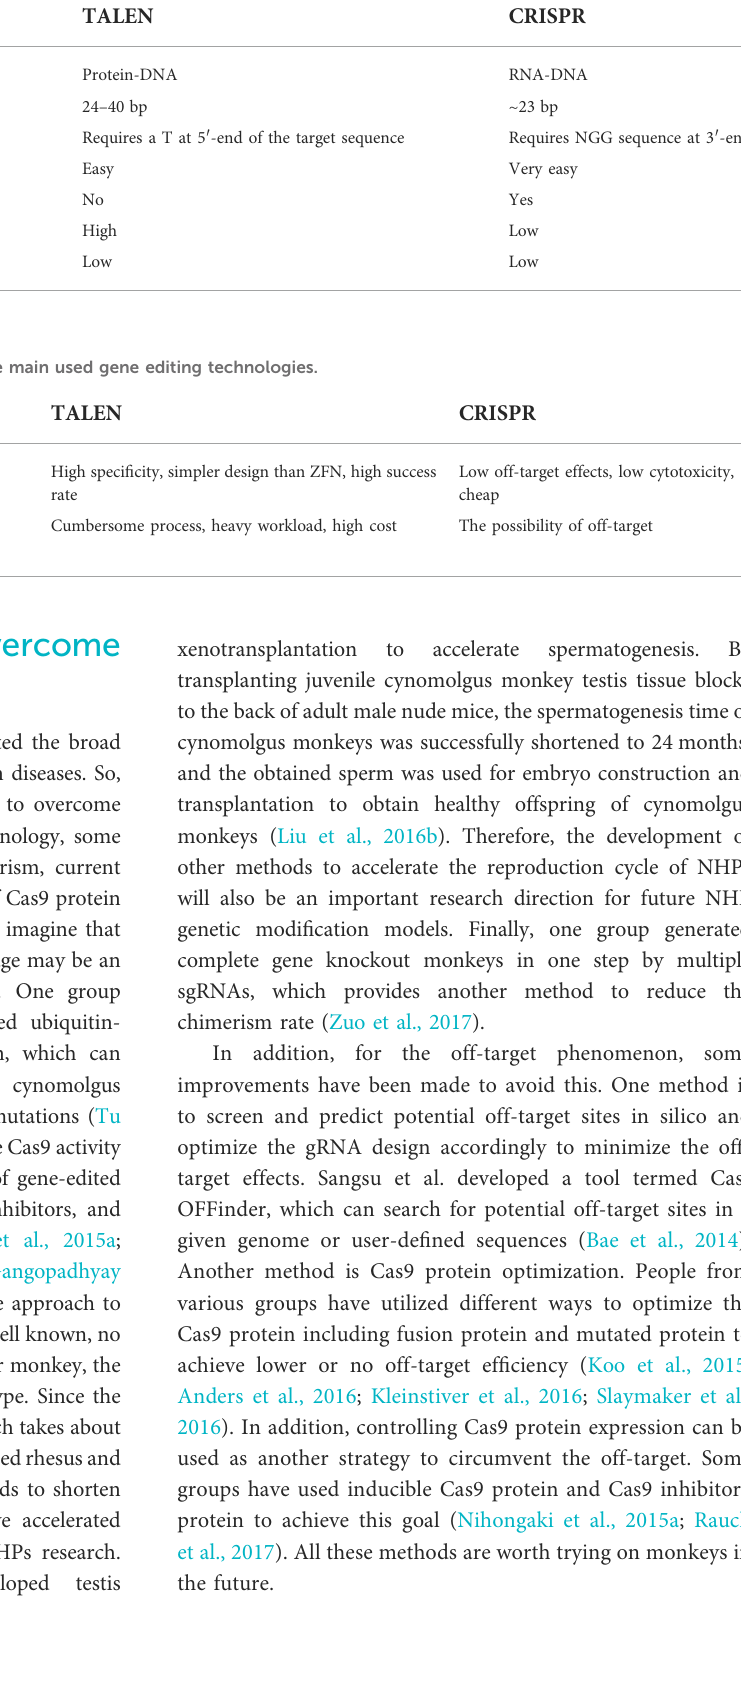
TABLE 3 Comparison of the three main used genome editing technologies in monkeys: ZFN, TALEN, and CRISPR.